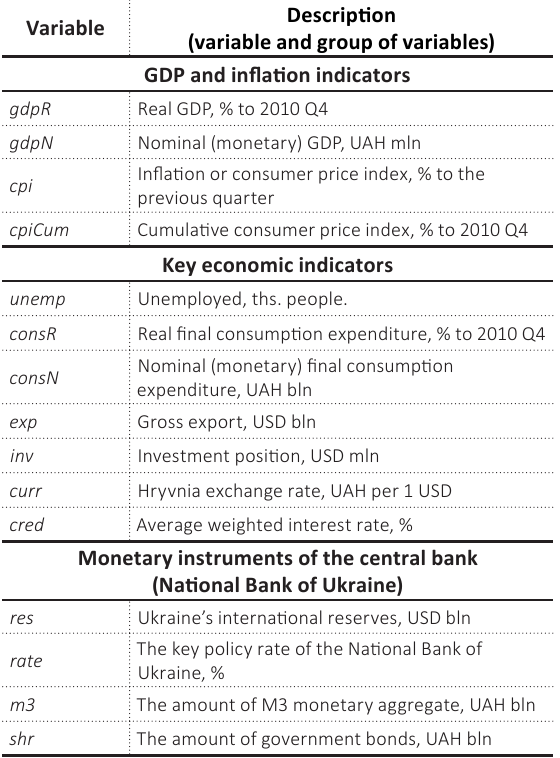
Table 1. Input and output variables for the effect of inflation targeting on macroeconomic